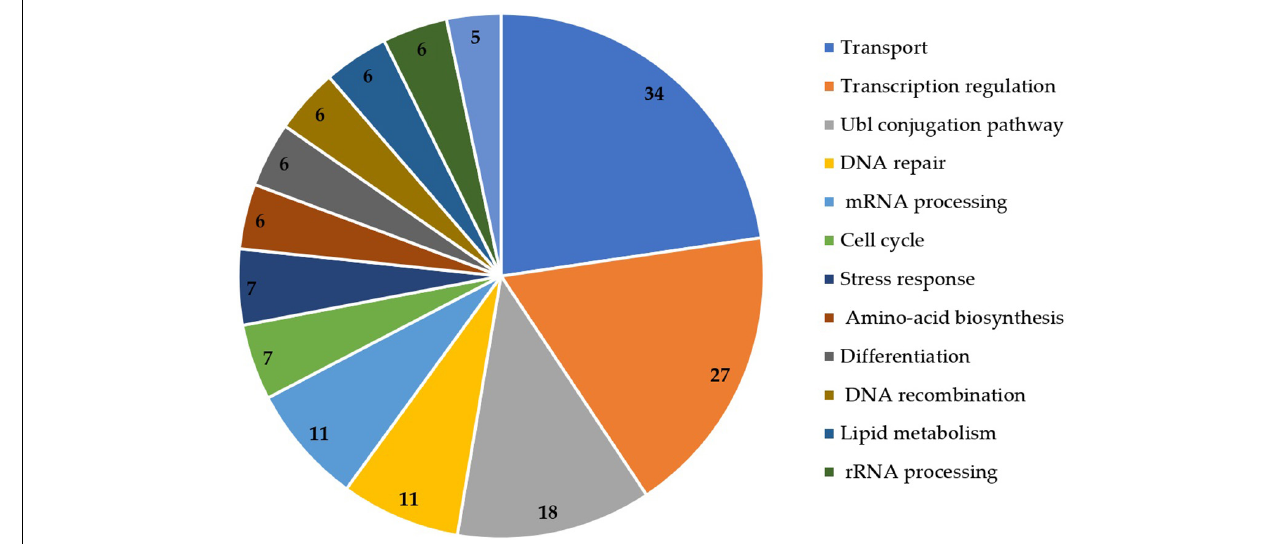
FIGURE 4 | Functional annotation of DEGs obtained from UniProt